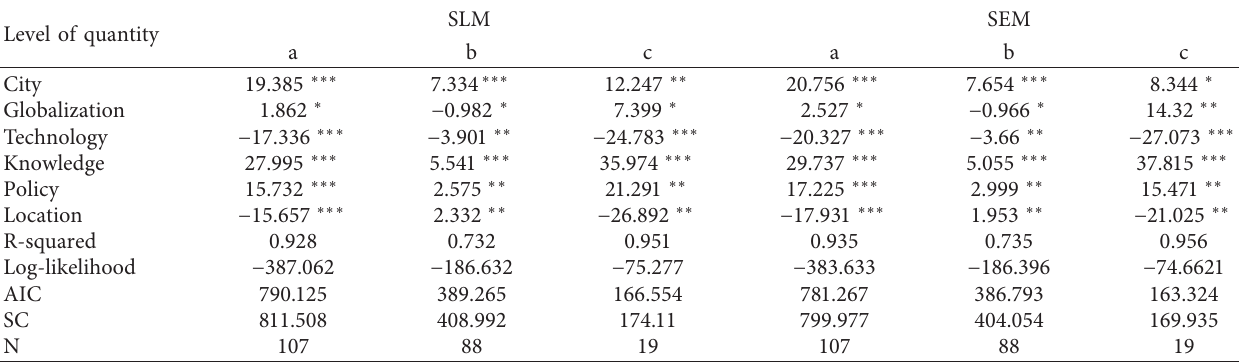
Table 3: Results of SLM and SEM regression analysis of each dimension.